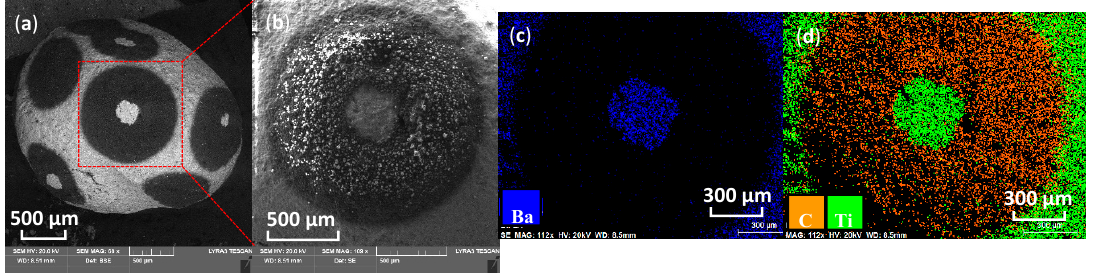
Figure5. ( a , b )SEMimagesand( c , d )EDXanalysisofcircularpatternsofsoliddepositsonBaTiO 3 surface. Figure 5. ( a , b ) SEM images and ( c , d ) EDX analysis of circular patterns of solid deposits on BaTiO 3 surface.